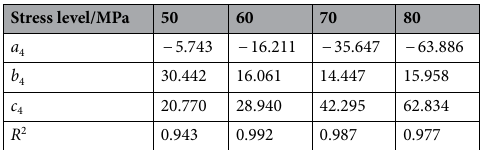
Table 2. Calculation result of S 11 / G 1